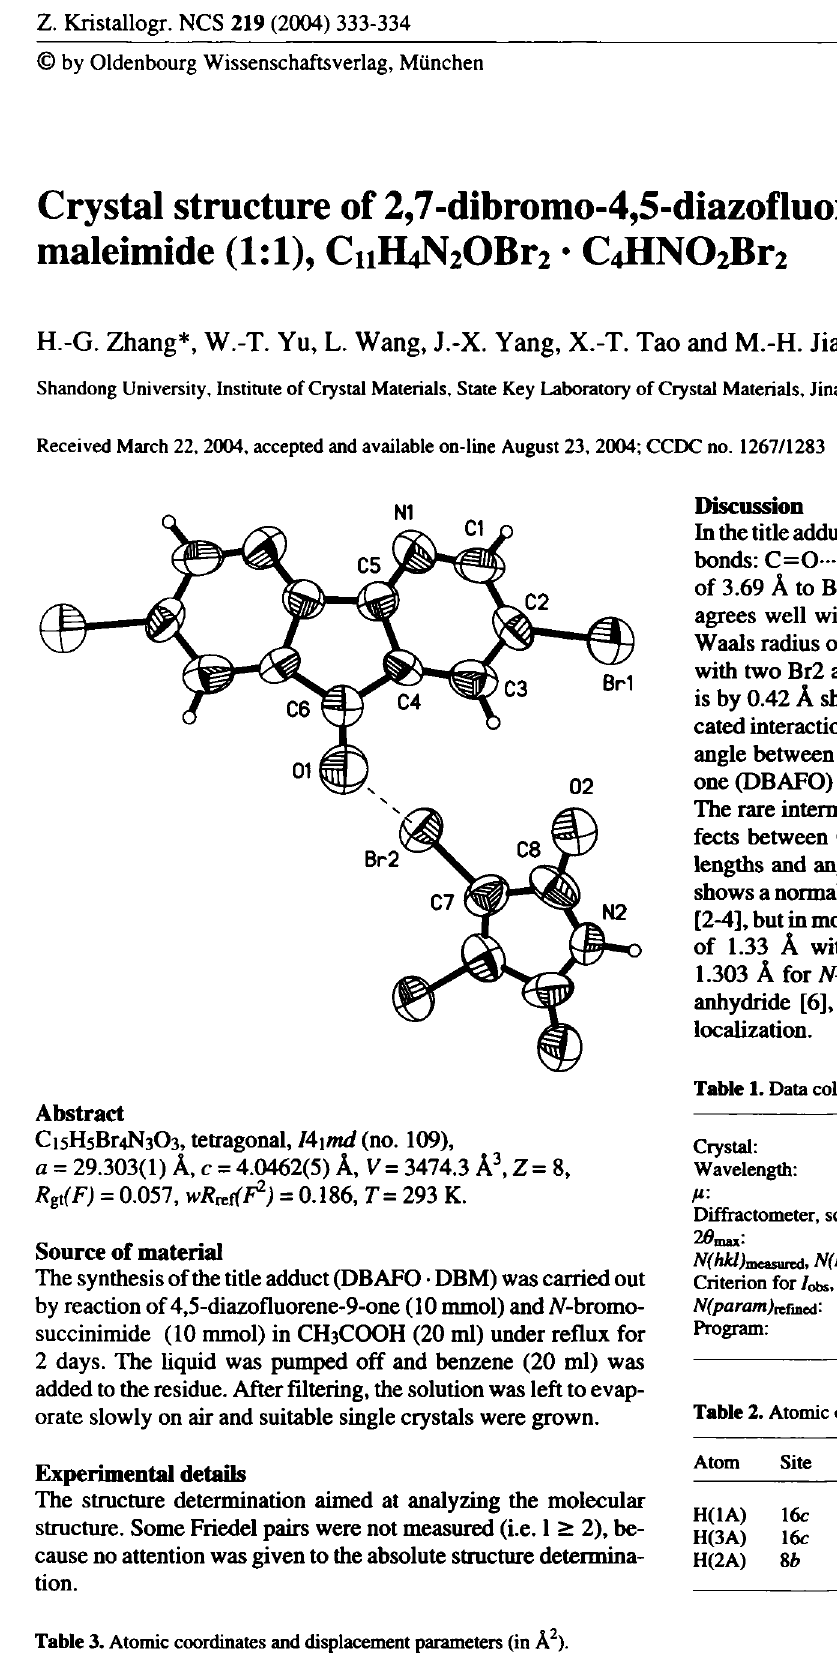
Table 3. Atomic coordinates and displacement parameters (in A 2 ).